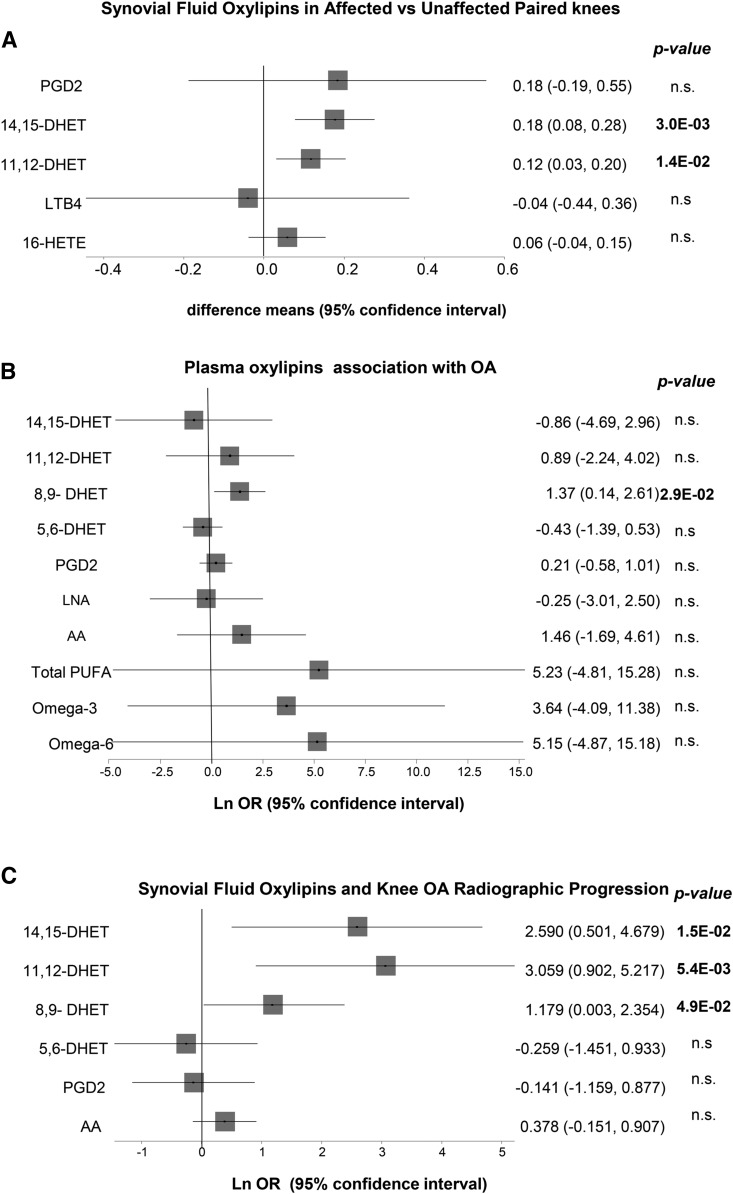
Forest plots showing the association between selected oxylipins. A: Difference between synovial fluid levels in affected and unaffected knees from 10 individuals with knee OA. P-values are derived from paired t-test analysis. B: Logistic regression coefficients for association between knee OA and plasma levels of total omega-3, total omega-6, AA, PGD2, and the four DHETs, total PUFA oxylipins associated with OA and related compounds. C: Logistic regression coefficients for association between radiographic progression and SF levels of selected oxylipins plus AA. All analyses are adjusted for age, sex, BMI and use of NSAIDs.